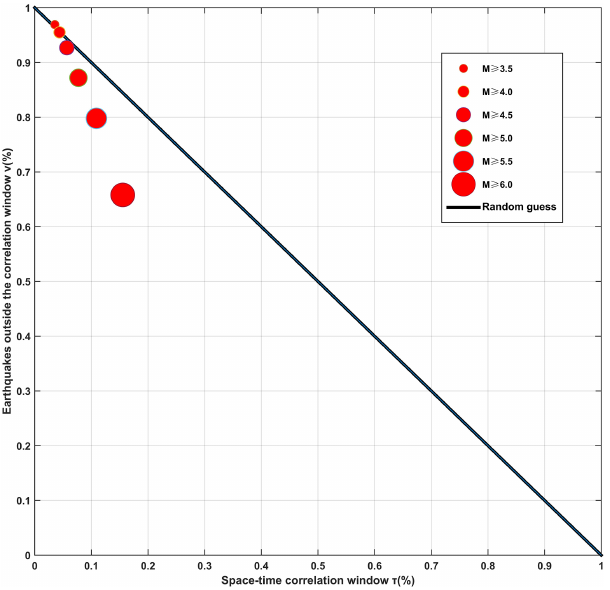
Figure 10. Molchan error diagram analysis computed for differ- ent classes of magnitude and TIR anomalies during the study pe- riod (from September 2002 to March 2018); the red circles refer to earthquakes that occurred before and after the appearance of TIR